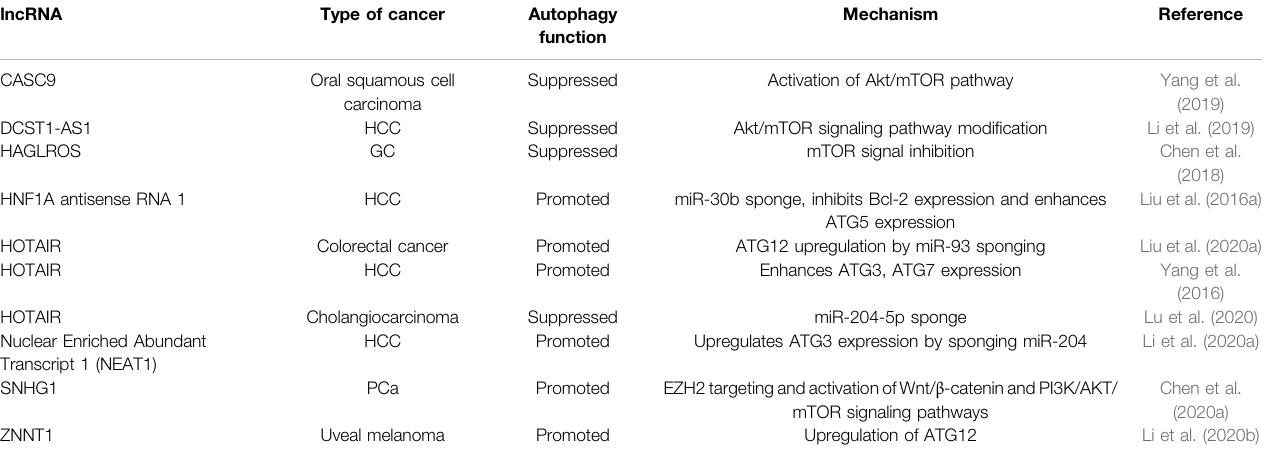
TABLE 1 | Role of lncRNA in autophagy. Hepatocellular carcinoma, HCC; Gastric cancer, GC; Prostate cancer,